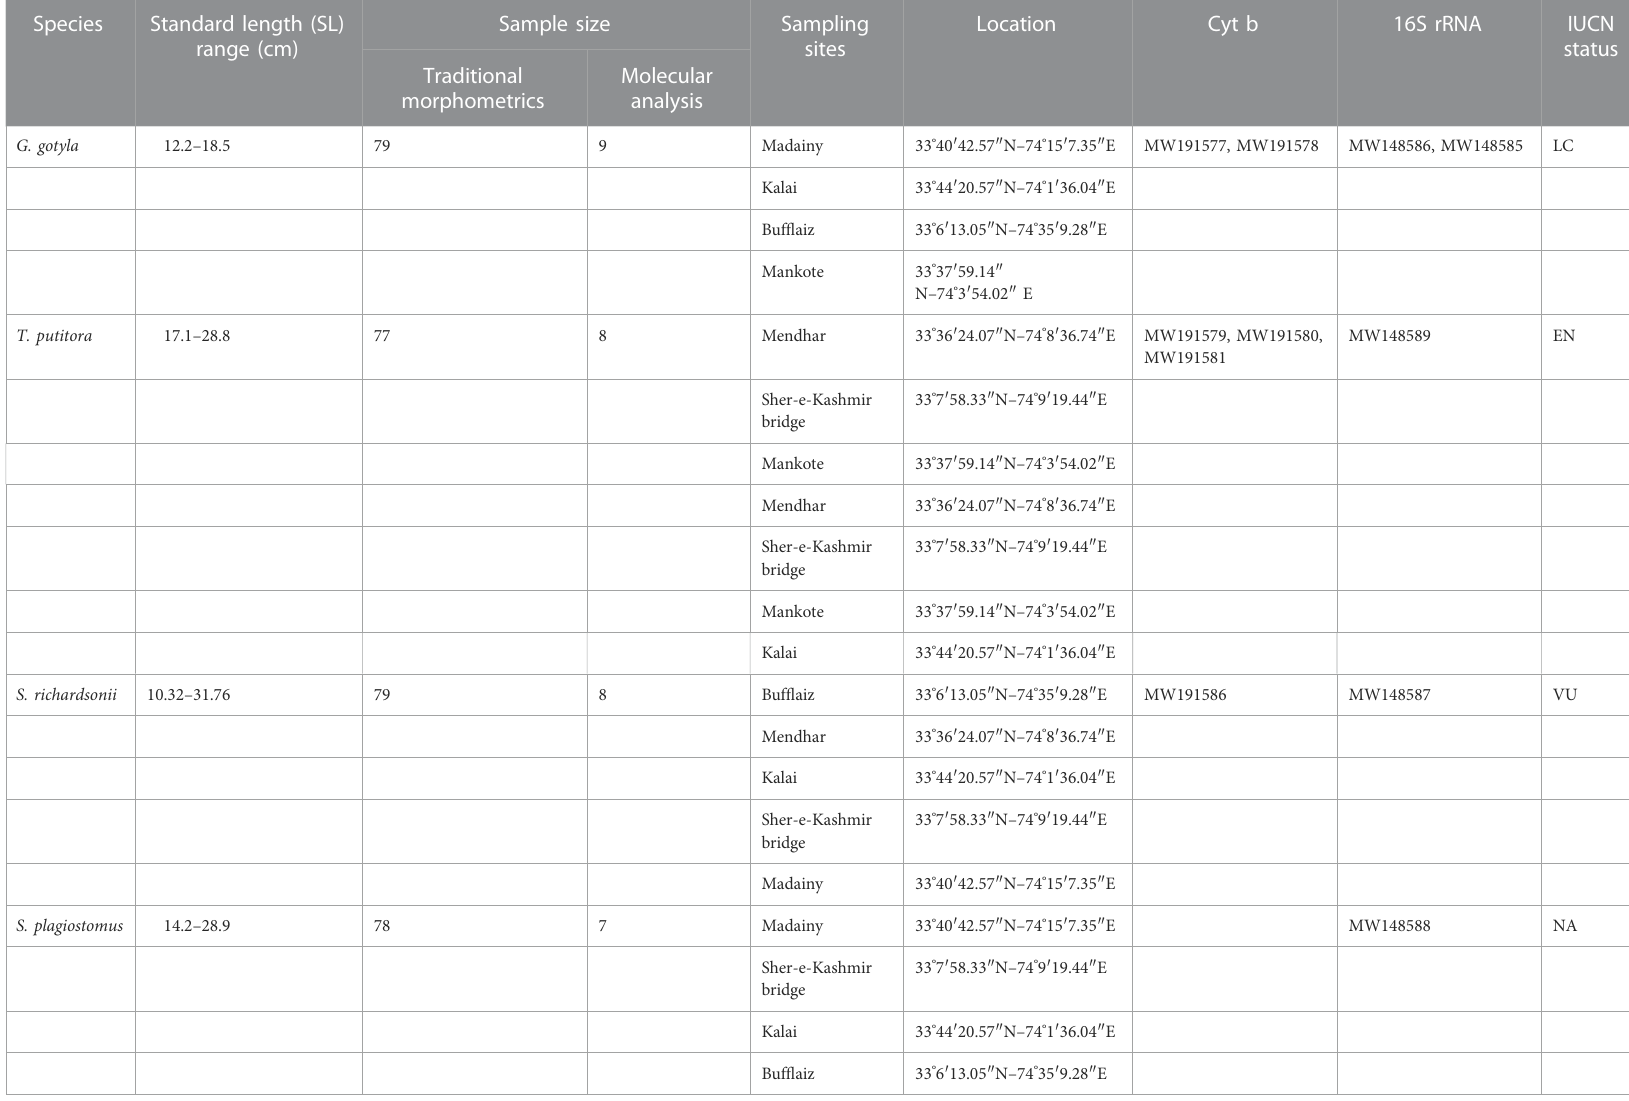
TABLE 1 Sampling sites, their locations with latitude and longitude, sample size and size range of six fi sh species used in the present study with GenBank accession